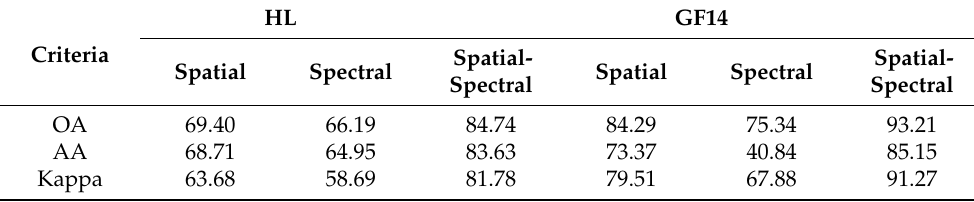
Table 7. Classification results (%) by 10% labeled samples with different modules. HL Criteria Spatial